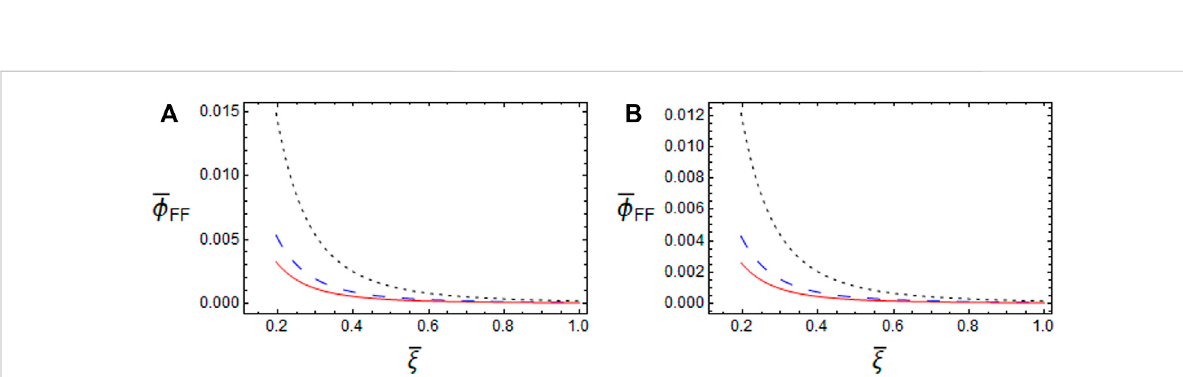
Figure 4 represents how a normalized FF potential ( affected by the normalized axial distance dust polarization R [ = 0.05766 (black dashed curve), 0.05769 (blue dashed curve), 0.05772 (red solid curve)] at z d 0 = 4007 and